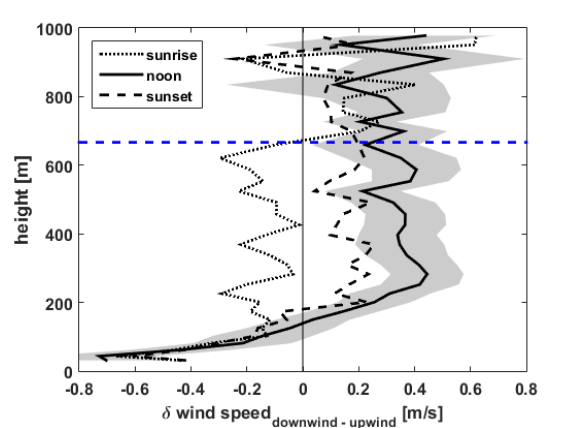
Figure 3: Vertical profile of mean difference in wind speed between the two DWL measurements at sunrise (dotted), solar noon (solid) and sunset (dashed). The grey shading represents the standard error of the mean. The blue dashed line shows the mean mixing layer height for the days included in the